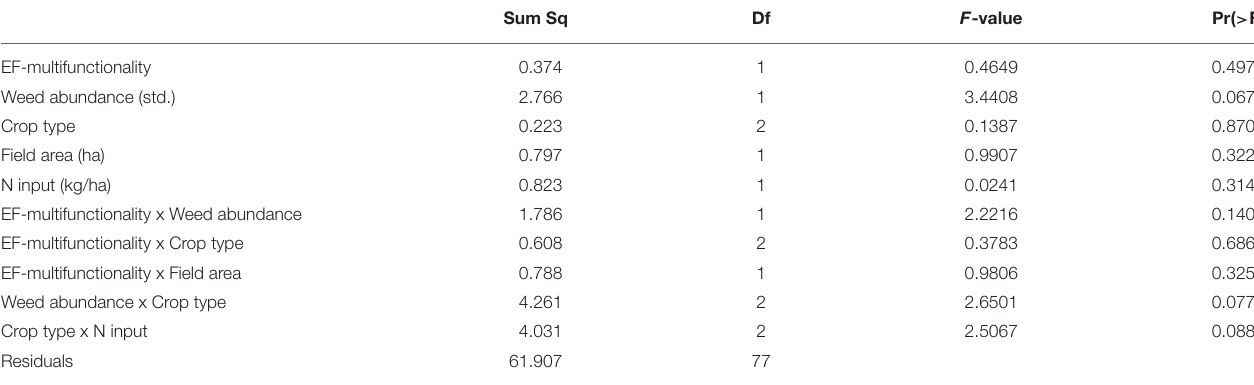
TABLE 3 | Statistics for the effects of EF-multifunctionality, crop type, amount of N input, weed abundance, field area and the interaction between EF-multifunctionality and crop type EF-multifunctionality and weed abundance, EF-multifunctionality and field area, as well as the interaction between weed abundance and field area and